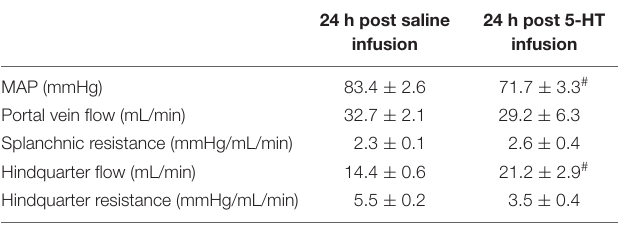
TABLE 1 | Regional hemodynamic effects after 24 h of 5-HT or saline infusion in anesthetized rats.